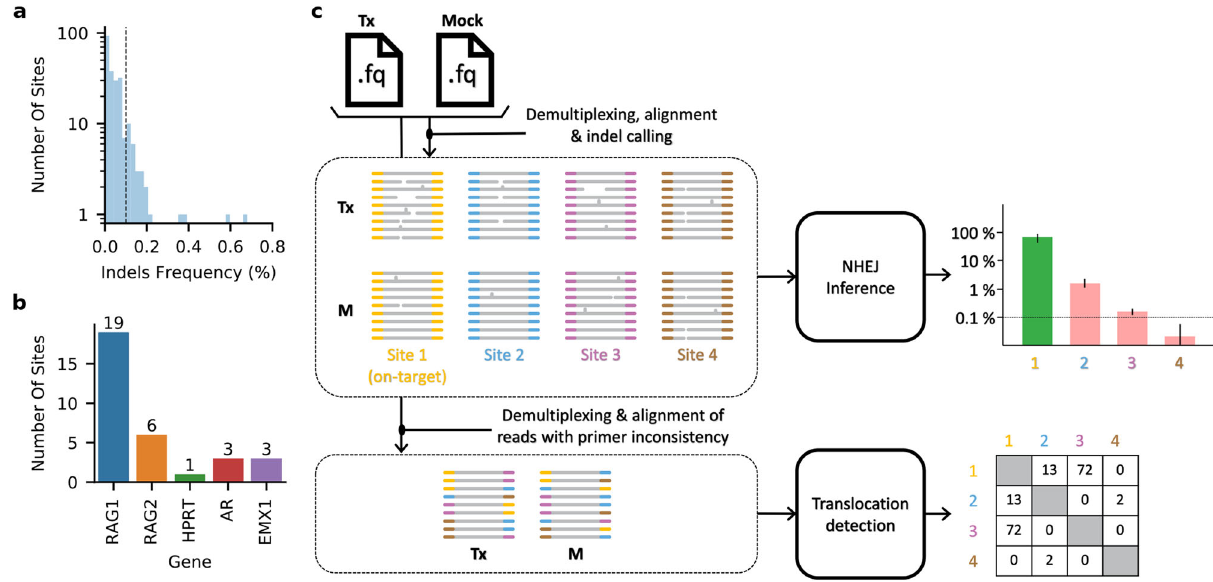
Fig. 1 Quantifying off-target activity by CRISPECTOR. a , b Hypothetical indels at the expected cut-site in the M experiments. a Out of 226 off-target sites that we have examined in our experimental data, we have found 31 sites to have indel frequency higher than 0.1% (fraction = 0.001) in the M experiments. M indel frequencies at the cut-site were measured by a direct calculation, not using a comparative set-up. b These 31 noisy off-target sites come from different gRNAs examined, as depicted. ( c ) CRISPECTOR work fl ow. CRISPECTOR assigns each read in the Tx and M FASTQ fi les to a speci fi c locus of interest or a putative translocation. Then, a Bayesian inference classi fi er accurately estimates the indel editing activity, and a hypergeometric test is performed to detect translocation